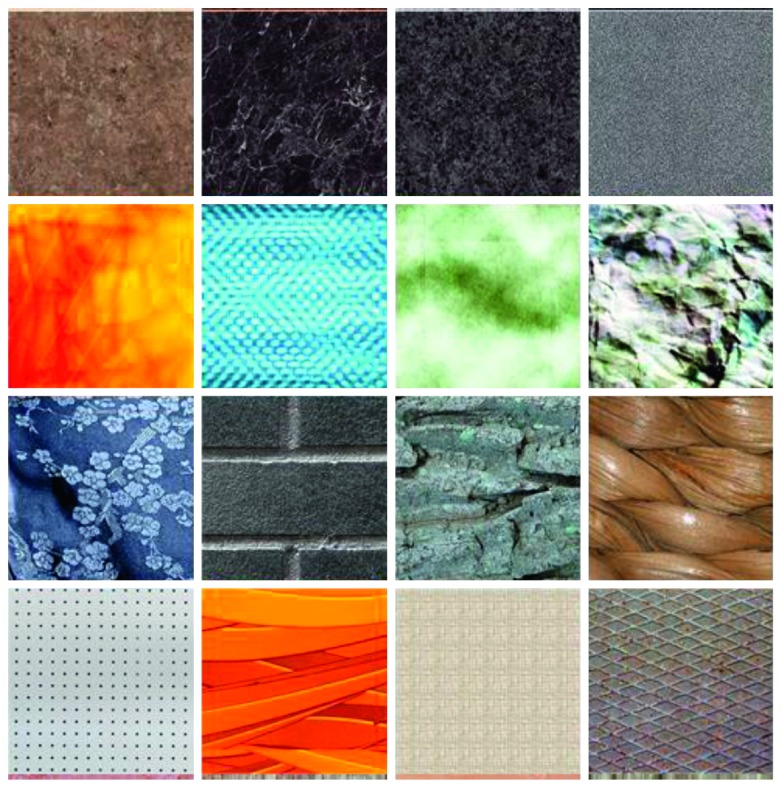
Example textures.